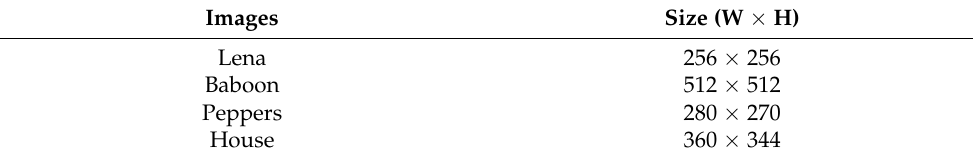
Table 2. Proposed